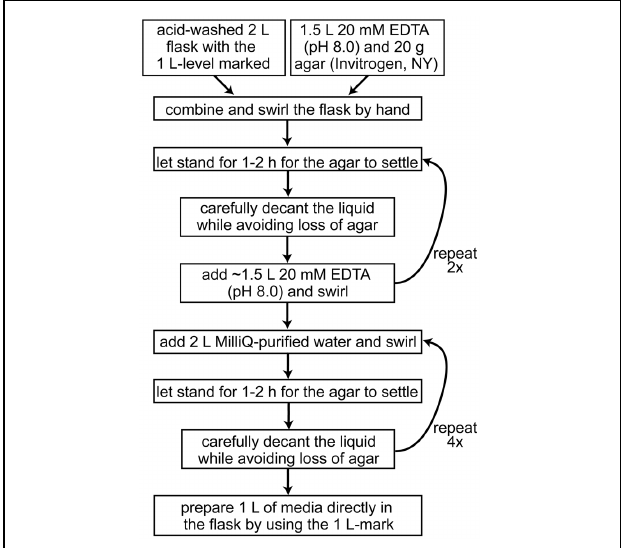
FIGURE 4 | Workflow for the preparation of iron-depleted solid growth media for Chlamydomonas.